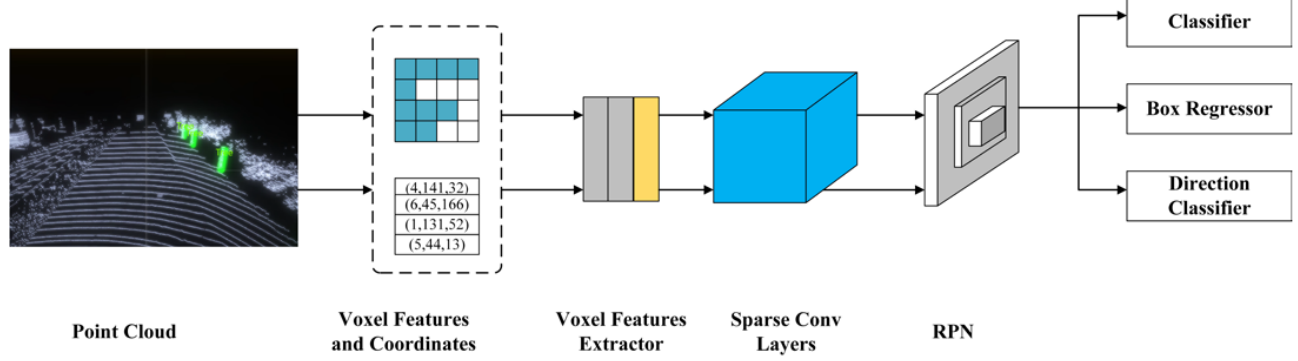
Figure 3. SECOND network